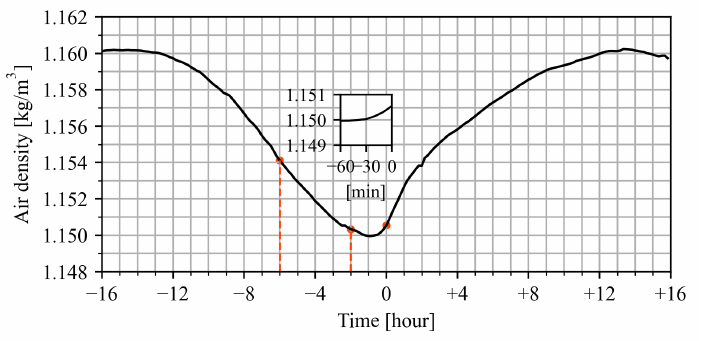
Figure 5. Composite of air density 16 h before and during rain. Red dots represent the 6 h, 2 h before rain, and the onset of the rain. The subplot is from 60 min before rain to the onset of rain. A total of 784 rain events is